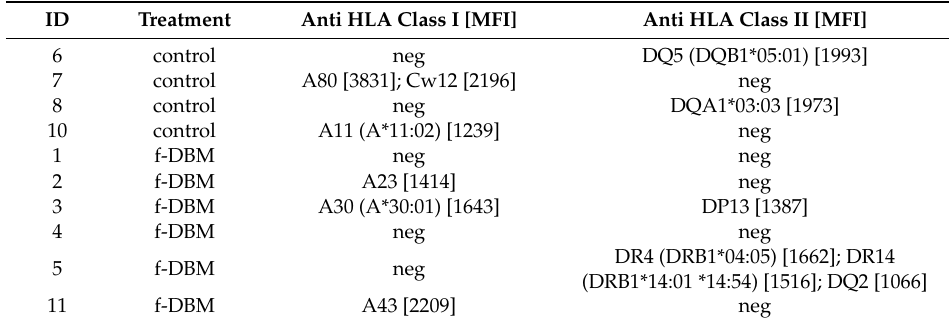
Table 5. Results of HLA measurements after two months. Results are shown in MFI, values greater 1000 were rated positive.